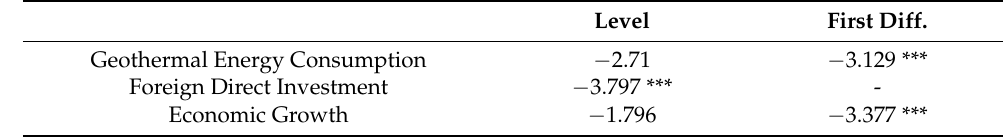
Table 4. CADF panel unit root test